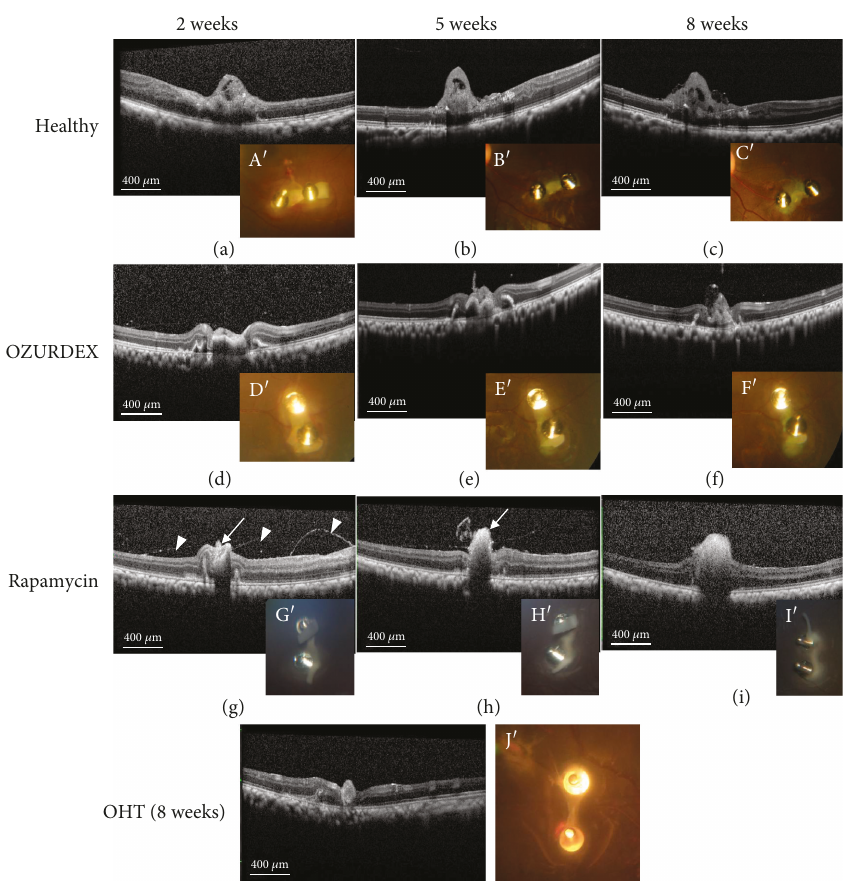
Figure 5: Changes in the retinal organoid after transplantation. In the healthy eye (transplanted with a retinal organoid, but receiving no immunosuppressive treatment), the transplanted retinal organoid sheet was clearly seen in the fundus photo. (A ′ ) In the early post- transplantation stage (2 weeks), the sheet was white. (B ′ , C ′ ) The green fl uorescence in retinal organoid cells became more apparent